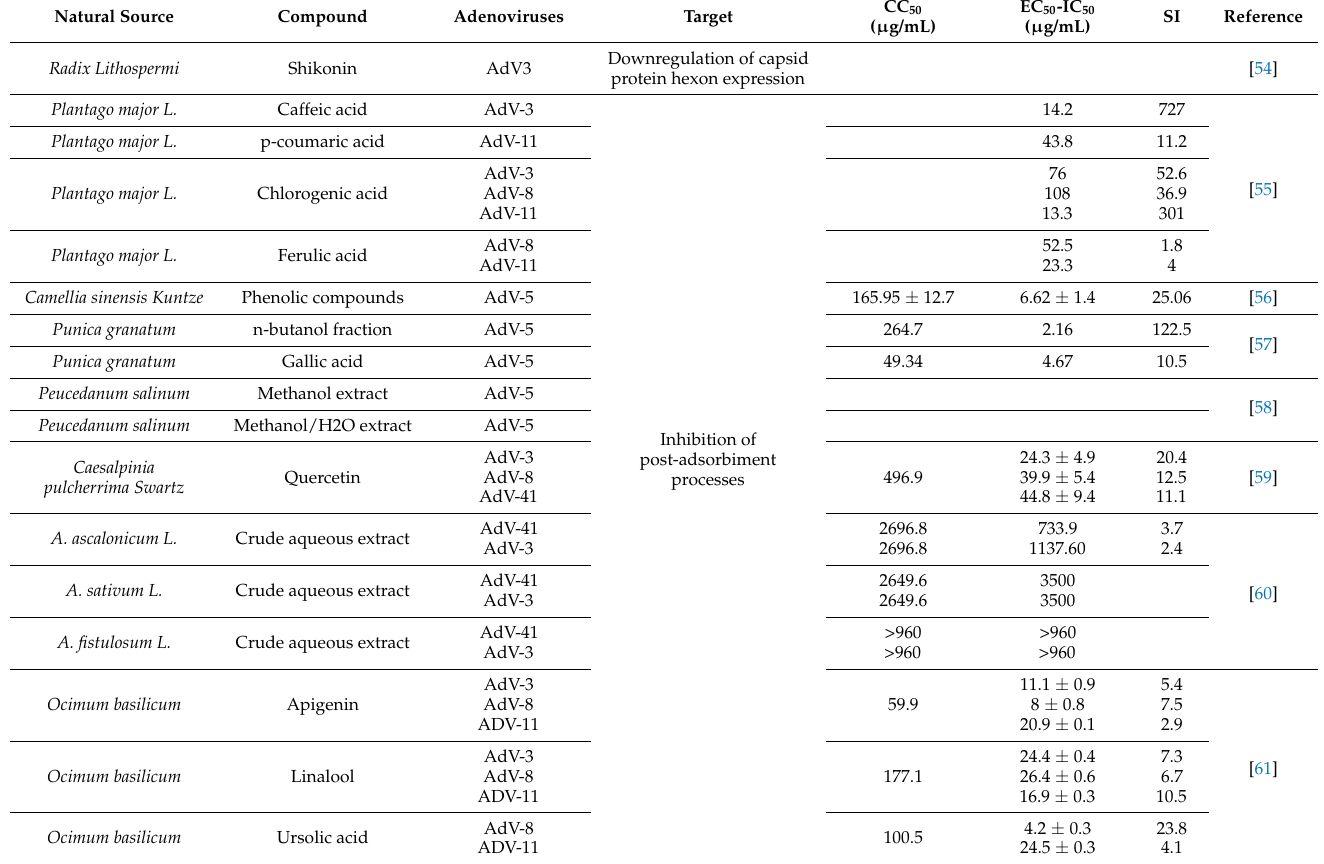
Table 4. Natural antiviral compounds against